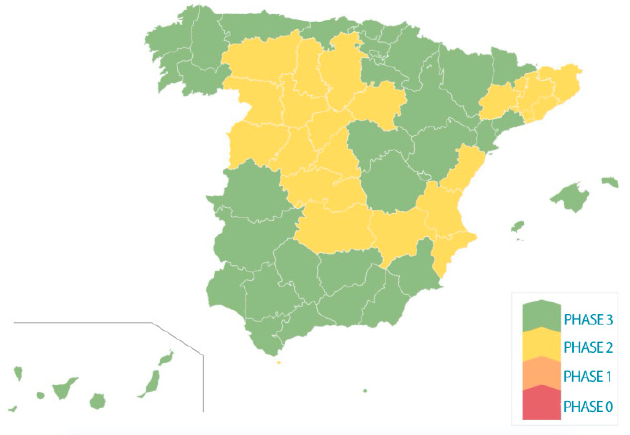
Figure 1. De-escalation process in provinces on 30 June, 2020. Notes: The activities allowed in each phase are conveyed in the notes below.